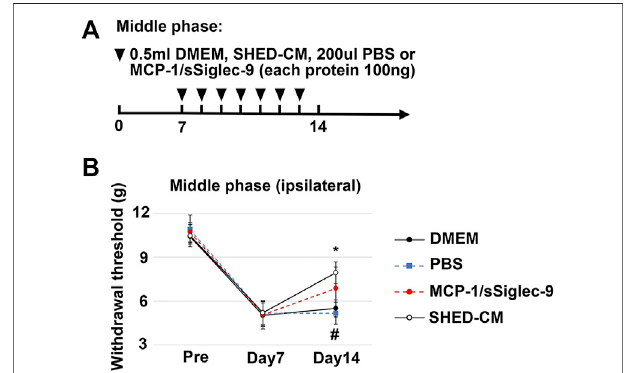
FIGURE 10 | Analgesic effect of MCP-1/sSiglec-9. (A) Time course of MCP-1/sSiglec-9treatmentinthemiddlephasemodel. (B) Theipsilateralpaw withdrawal thresholds in the middle phase model. Tukey ’ s multiple comparisonsofmeans( n =5ineachgroup).* p < 0.05,fortheSHED-CM vs. DMEM. # p < 0.05 for the MCP-1/sSiglec-9 vs.